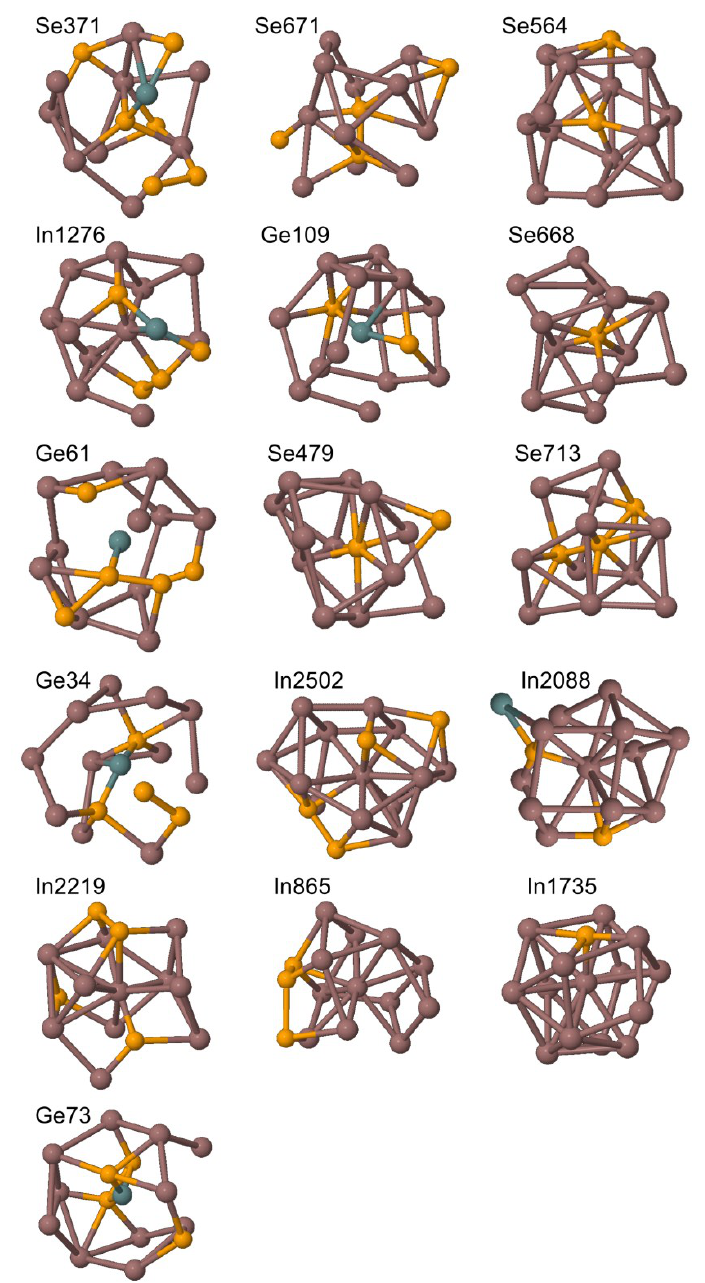
Figure 4. Geometries of the most representative clusters as isolated from the RMC supercell. Cluster designations refer to Table 3. Color coding is as follows: In, dark purple; Se, orange; and Ge, dark